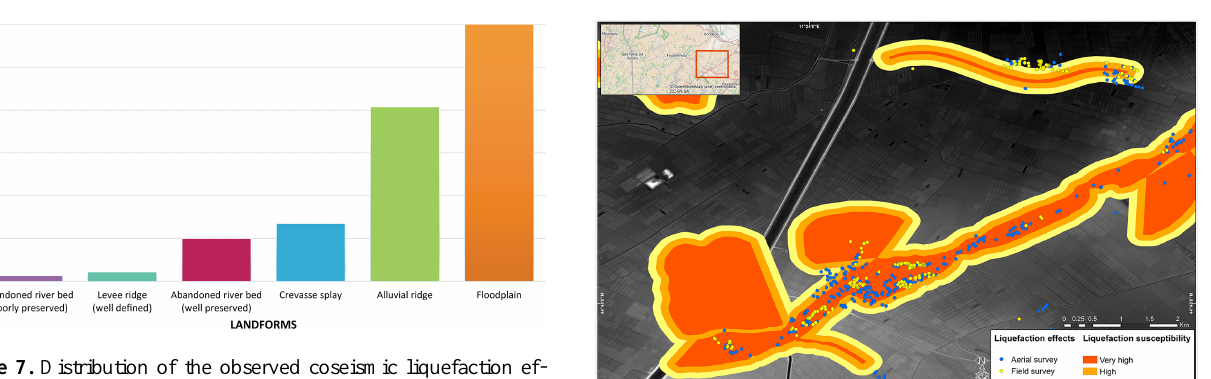
Figure 7. Distribution of the observed coseismic liquefaction ef- fects with respect to mapped fluvial landforms and to the floodplain (see Fig. 6). Figure 8. Liquefaction susceptibility hierarchy map for the Sant’Agostino village area (see Fig. 1 for location). In the back- ground the 1m pixel DTM of the area: elevations are in gray scale from highest (white) to lowest (black)